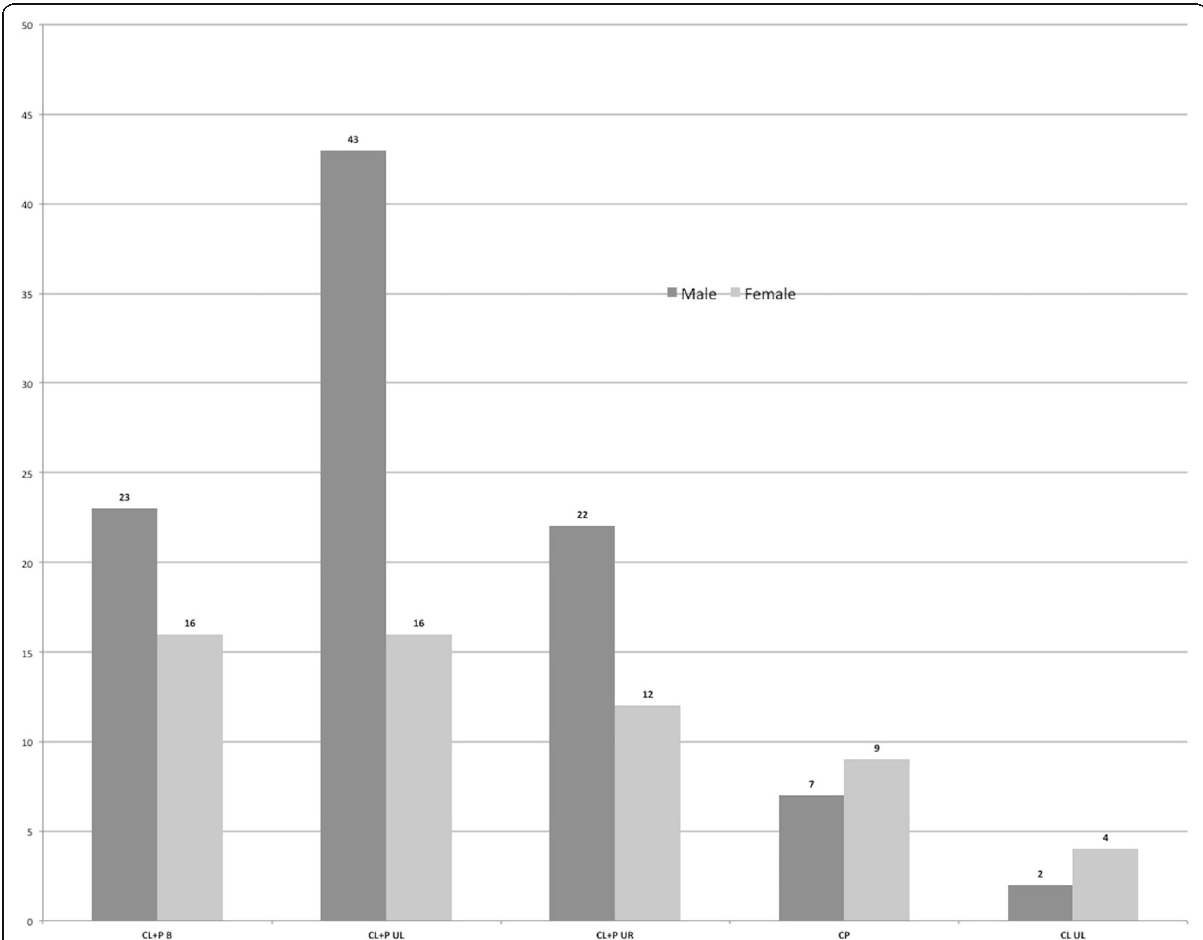
Fig. 1 Sample distribution by cleft type and gender. p Fisher ’ s,